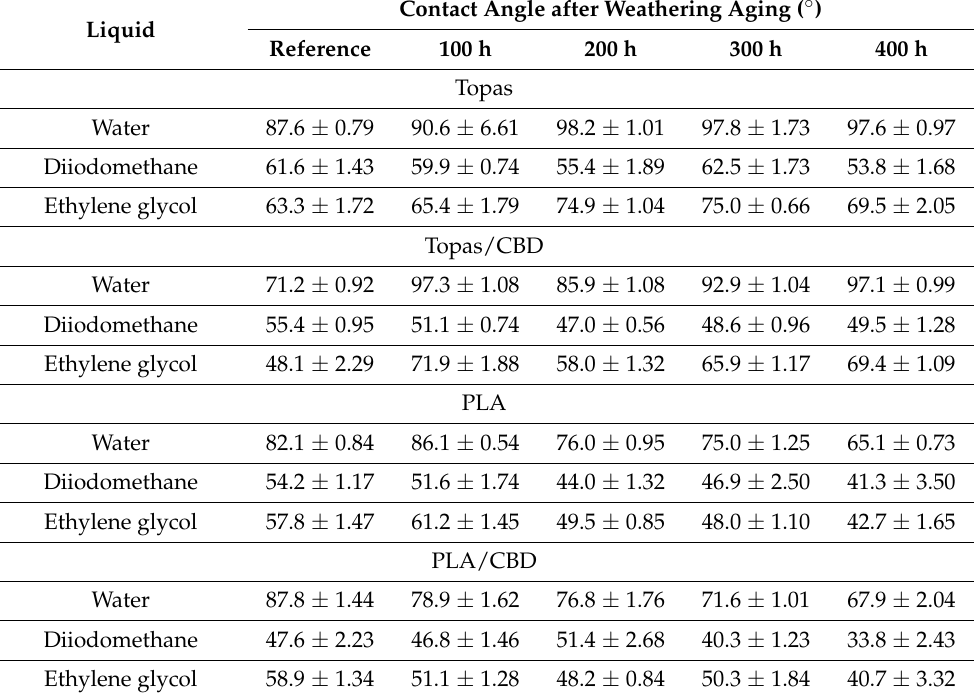
Table 1. Contact angle values determined by using distilled water, ethylene glycol, and 1,4- diiodomethane for ethylene–norbornene copolymer (Topas) and polylactide (PLA) mixtures before and after weather-aging. Each value is the average of 10 determined contact